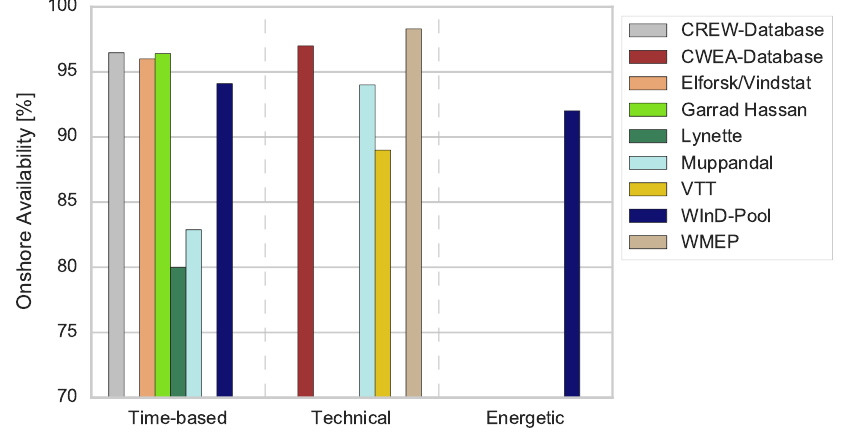
Figure 3. Availability of onshore WT as published by different